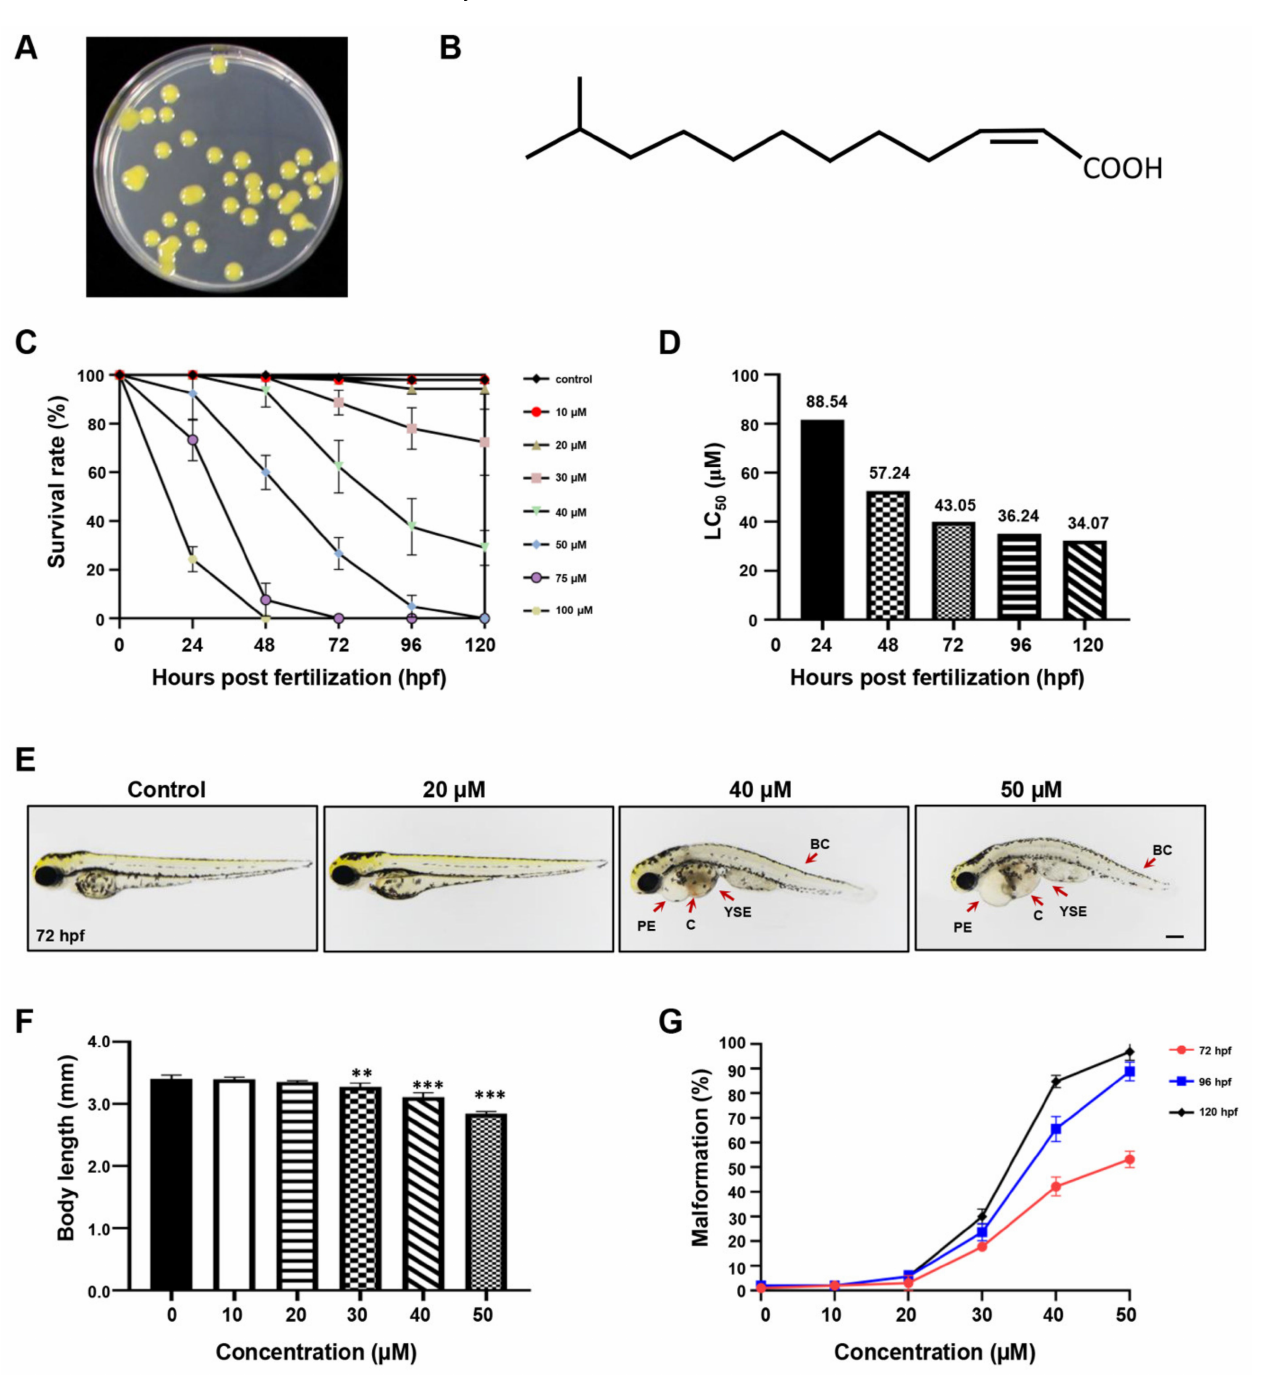
Figure 1. The effect of DSF on zebrafish embryos. ( A ) DSF producer Xcc . ( B ) The chemical structure of DSF. ( C ) The survival rate of embryos treated with different doses of DSF at 24, 48, 72, 96, and 120 hpf. ( D ) LC50 of DSF-treated embryos. ( E ) DSF-treated embryos (0, 20, 40, and 50 µ M) revealed different malformed phenotypes at 72 hpf. PE, pericardial edema; YSE, yolk sac edema; C, congestion; BC, body curvature. ( F ) The body length was calculated at 72 hpf after embryos were treated with different doses of DSF. ( G ) Quantification of the malformation rate at 72, 96, and 120 hpf embryos after treatment with different doses of DSF. The LC 50 was calculated with IBM SPSS 22 statistics. The values are represented as mean ± S.D. ** p < 0.01, *** p < 0.001. Scale bar, 200 µ